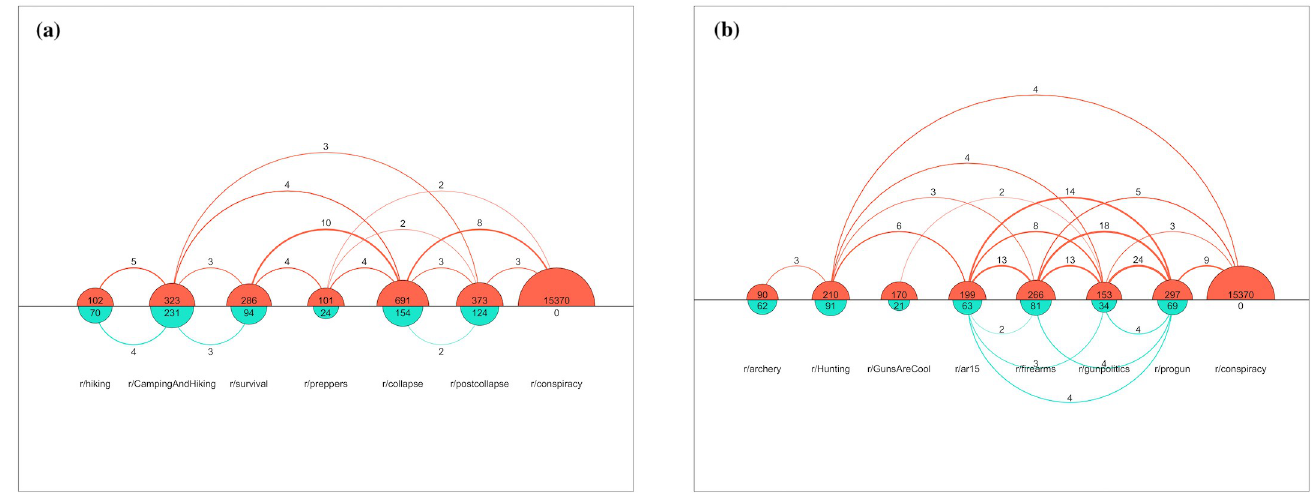
Fig 2. Chronological posting patterns. Examples of chronological posting patterns among r/conspiracy (orange, above) and control group (cyan, below) users for selected subreddits in the “Guns & Cars” theme community. Numbers within semi-circles are the total number of users posting in the subreddit; numbers above and below arcs are the number of users with contiguous chronological posts in two subreddits (from left to right).